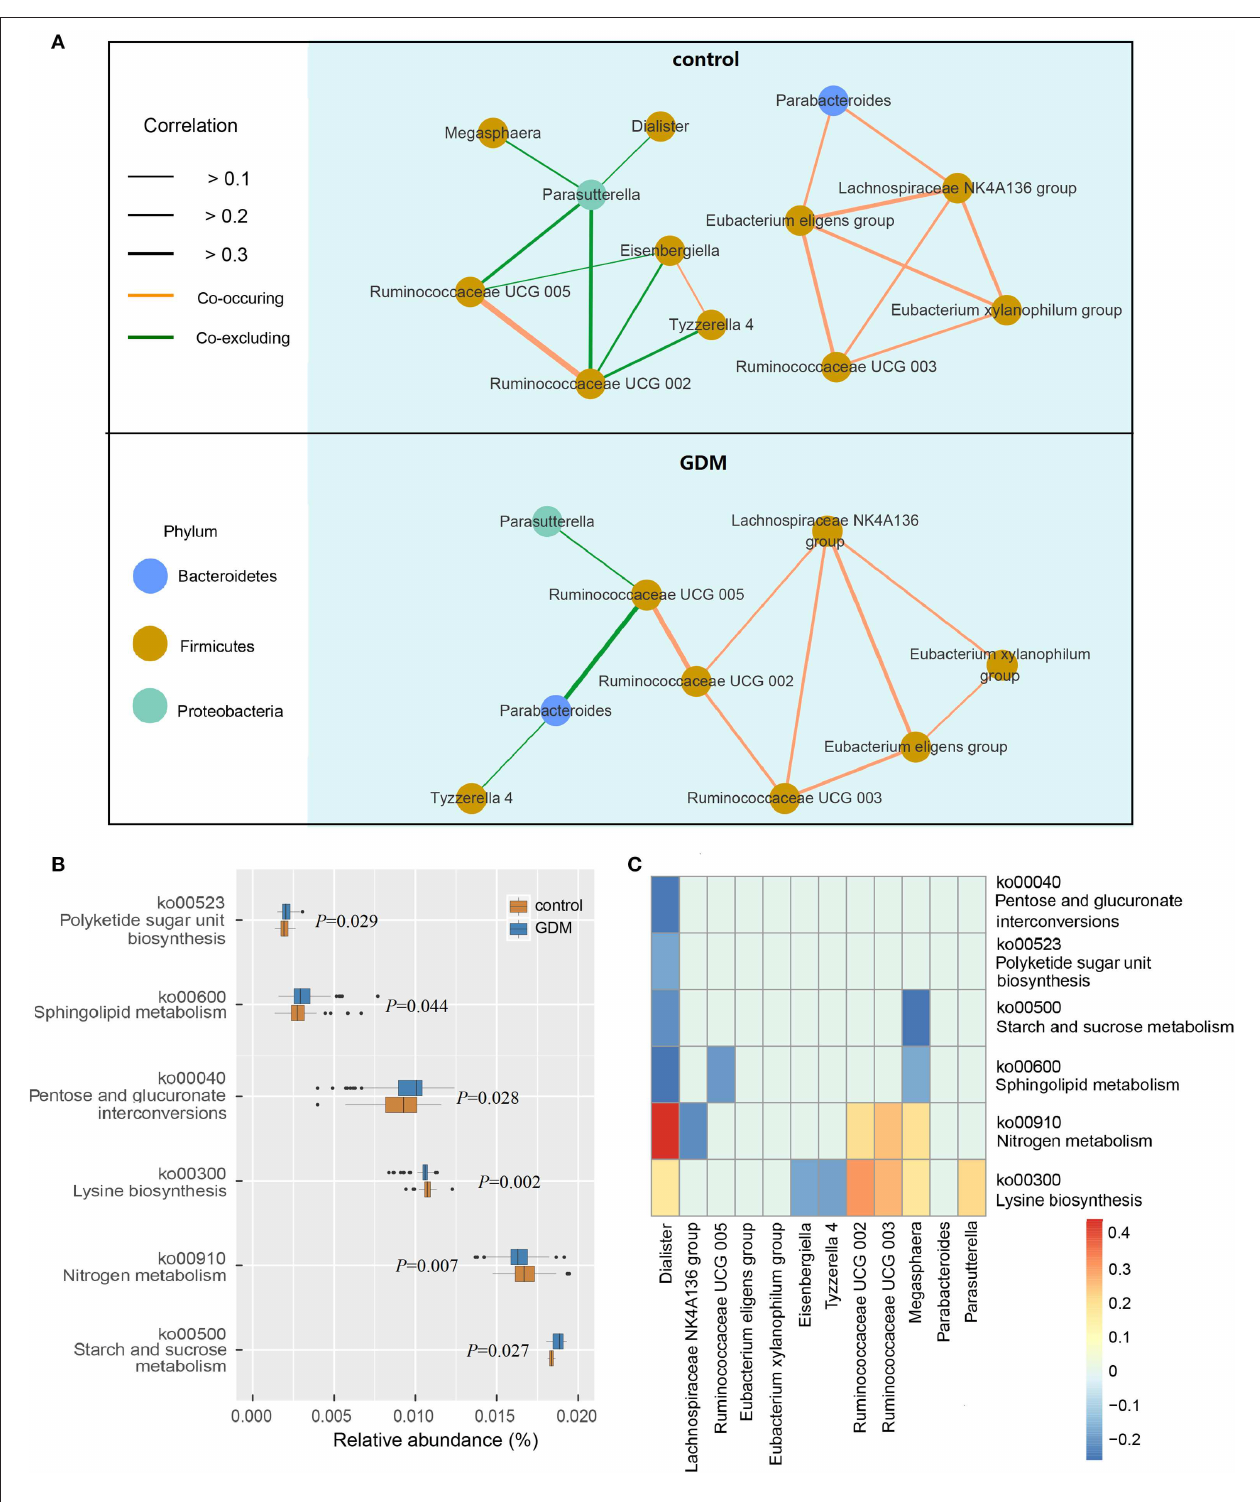
FIGURE 3 | Functional analysis of the gut microbiota in healthy control and GDM groups. (A) Co-occuring and co-excluding networks for differential genera in control and GDM groups (yellow line: co-occuring; green line: co-excluding). (B) Boxplot of differential functions between control and GDM groups. The differential pathways were identified using Tax4Fun and LEfSe, the P -values next to each boxplot. (C) Heatmap of Spearman’s rank correlations between differential genera (LEfSe: P < 0.05 and linear discriminant analysis threshold value > 2) and differential pathways. Bars that tend to red and tend to blue represent positive and negative correlations,